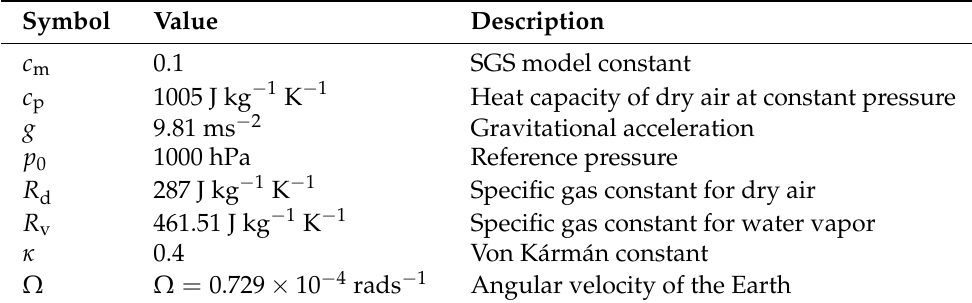
Table 1. List of general parameters in PALM model